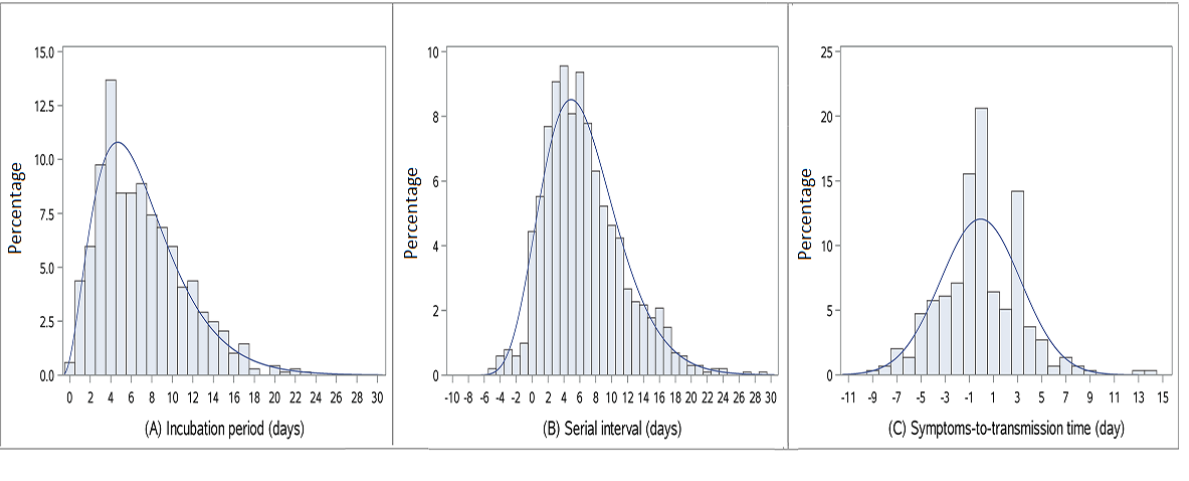
Symptoms-to-transmission timeSerial intervalIncubation periodMetrics